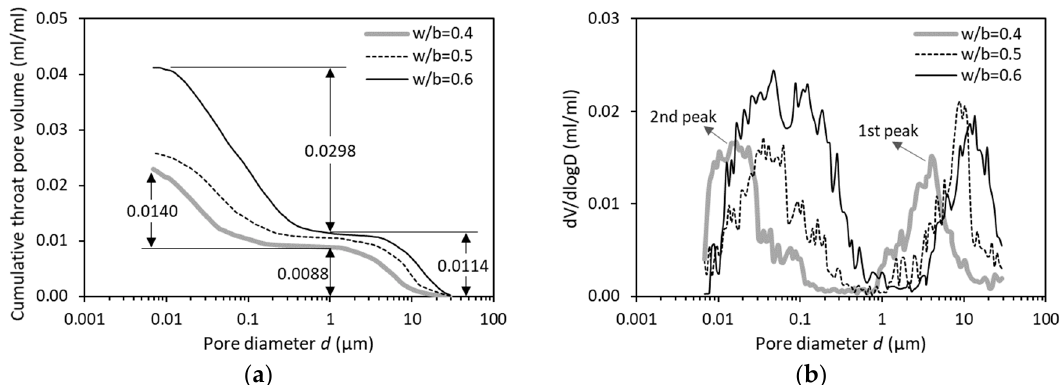
Figure 6. ( a ) Distribution of throat pores and ( b ) differential curves for OPC pastes (28 days) with w/b of 0.4, 0.5 and 0.6.